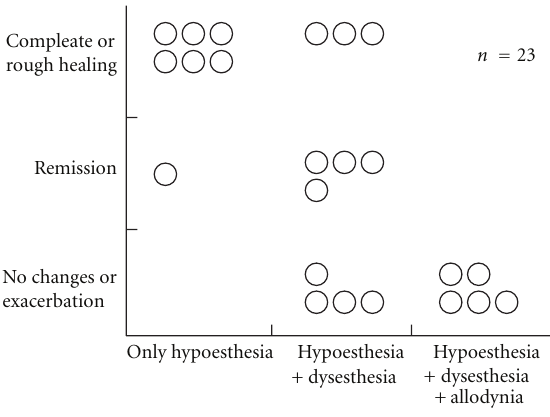
Figure 11: Prognosis and subjective symptoms [19].